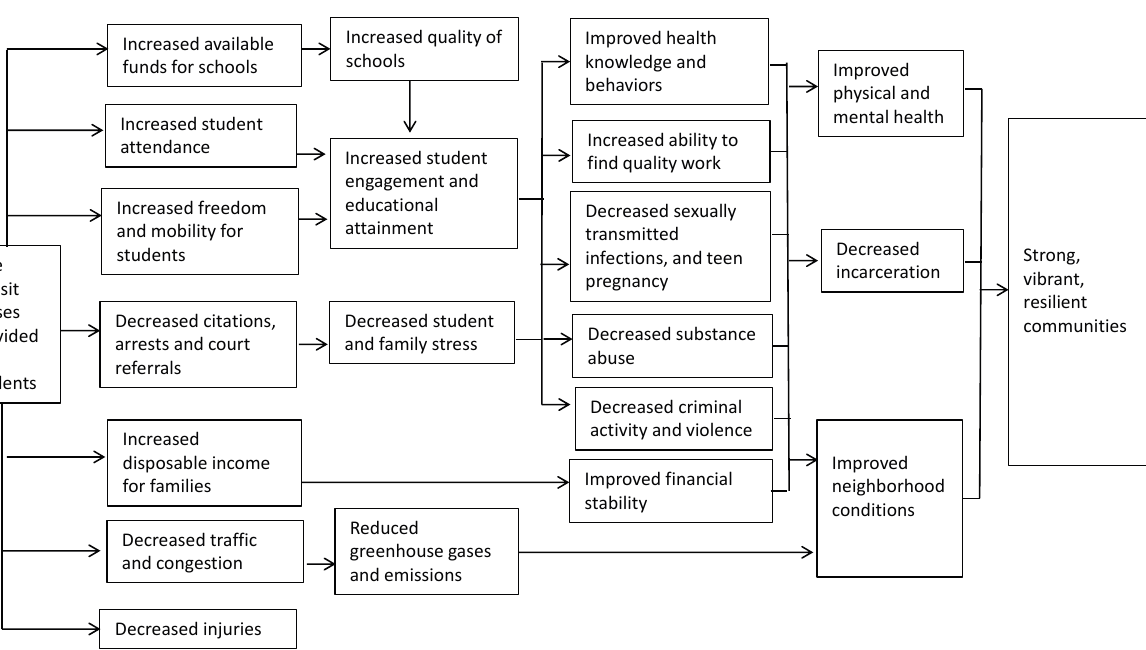
Figure 1. Potential benefits of providing free public transit passes to students, pathway diagram, Los Angeles, California 1